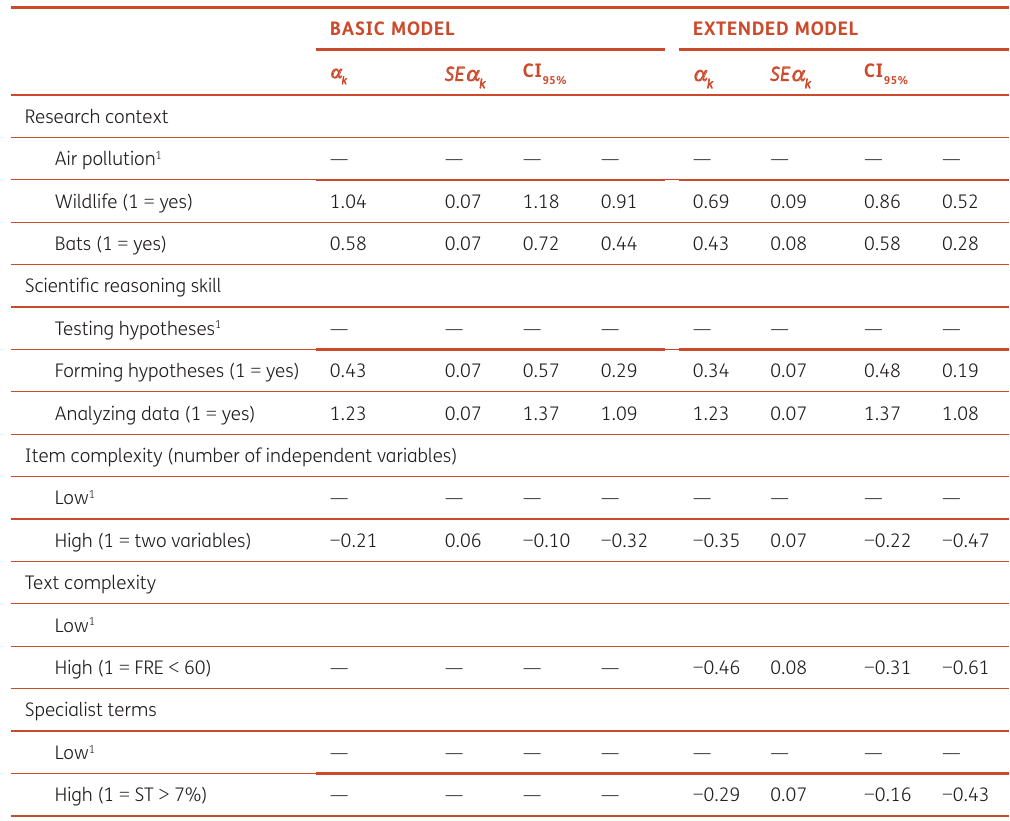
Table 3 Estimated parameters in the LLTMs with standard error ( SE ) and confidence interval (CI). Note : FRE: Flesch Reading Ease Index; ST: specialist terms. 1 We compared estimated a parameters with the values of this reference k